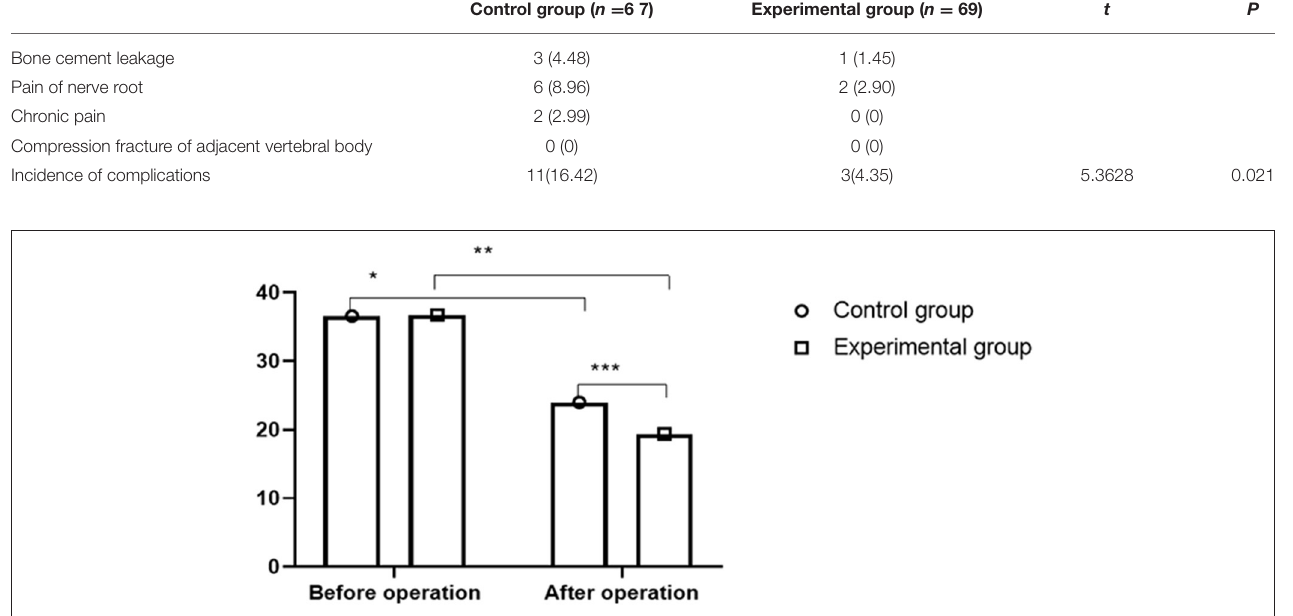
FIGURE 3 | Comparison of ODI scores between two groups ( x ± s). The abscissa indicates preoperation and postoperation, and the ordinate indicates score. ODI scores of control group before and after operation were (36.54 ± 3.37) and (23.97 ± 3.58), respectively. ODI scores of in experimental group before and after operation were (36.72 ± 3.35) and (19.37 ± 3.46), respectively. * indicates ODI score of control patients after operation was significantly lower than that before operation ( t = 19.1320, P < 0.01); ** indicates ODI score of experimental patients was significantly lower than that before operation ( t = 27.4362, P < 0.01); *** indicates ODI scores of two groups were significantly different after operation ( t = 6. 9765, P <